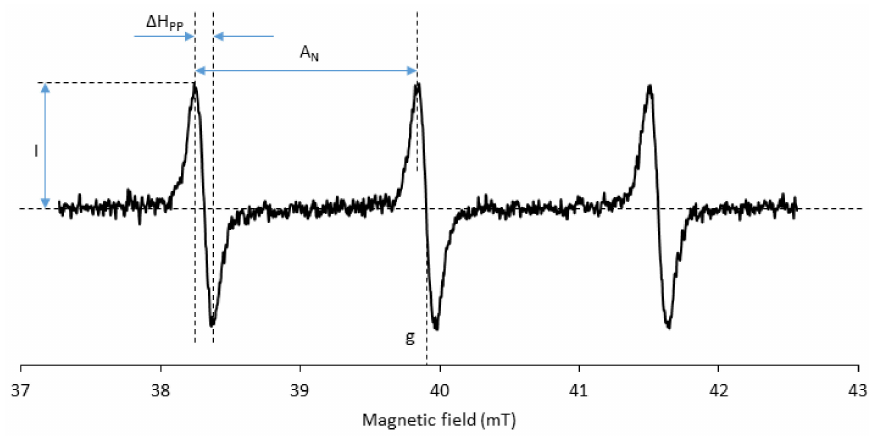
Figure 8. A typical L-band EPR spectrum of a 14 N-nitroxide radical in aqueous solution at 21 ◦ C; g—g factor; A N —hyperfine coupling constant to nitrogen; ∆ H pp —linewidth; I—signal intensity.